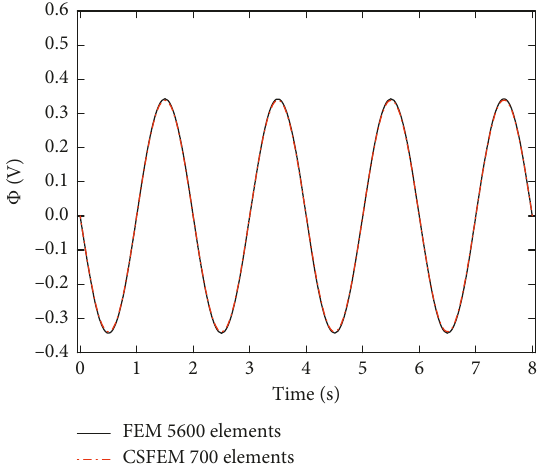
Figure 30: The variation of the electrical potential V of the PCMs energy harvester at point B with respect to